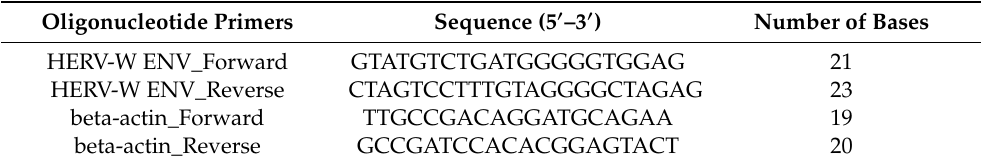
Table 1. Oligonucleotide Primers for Human Endogenous Retrovirus W Envelope RT-PCR. Oligonucleotide